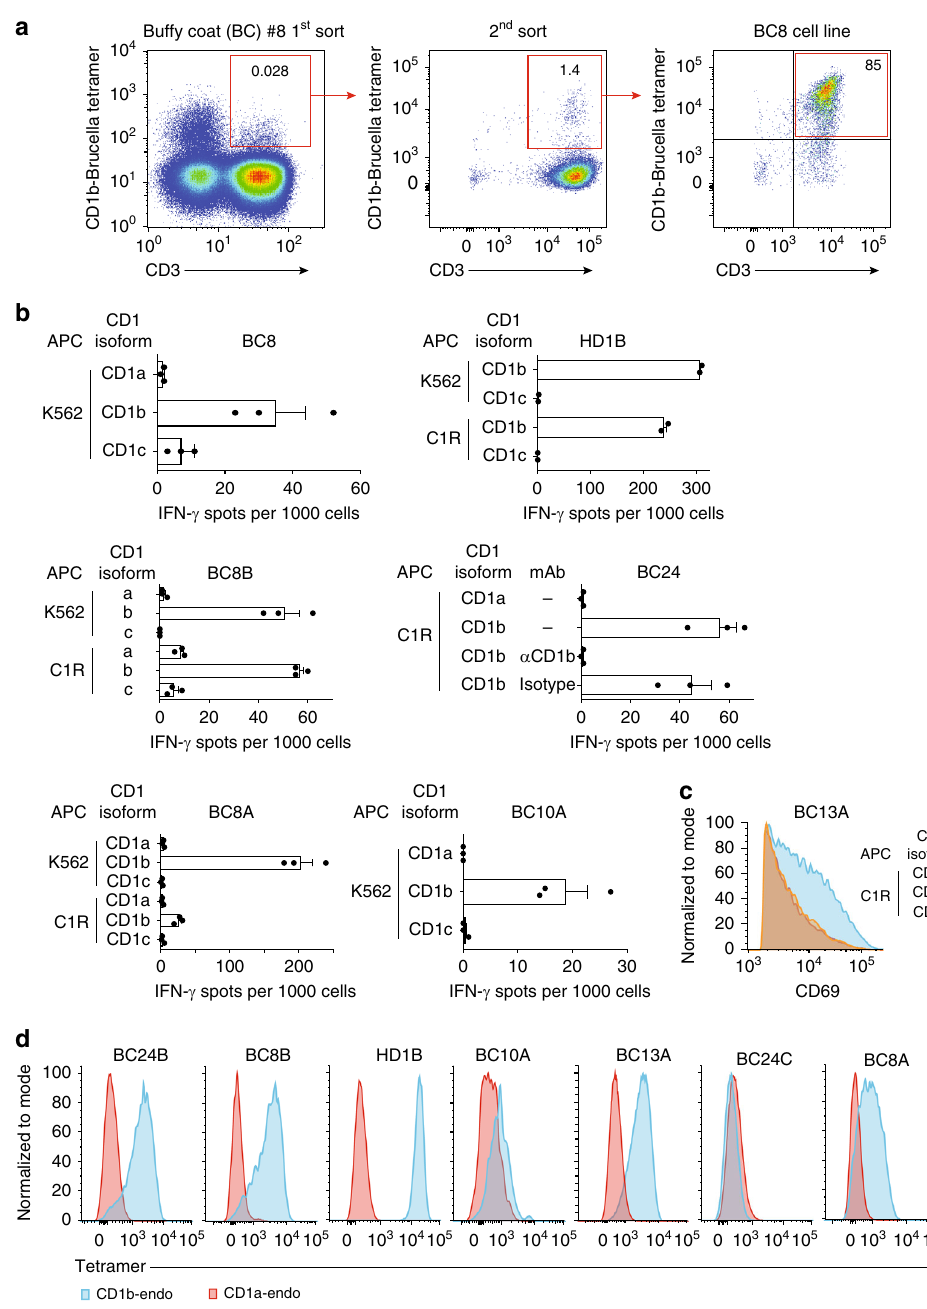
Fig. 1 CD1b tetramer selection generates autoreactive T-cell lines. a Peripheral blood mononuclear cells from blood bank-derived buffy coat 8 (BC8) were sorted based on expression of CD3 and binding to CD1b tetramers treated with Brucella lipid extract, followed by expansion in vitro. Numbers in the outlined red areas indicate percent cells in gate. The generation of additional T-cell lines is shown in Supplementary Figures 1 – 5. b IFN- γ ELISPOT assay of T-cell lines and subpopulations stimulated with K562 or C1R cells transfected to express CD1a, CD1b, or CD1c in the absence of exogenously added antigen. Error bars represent standard error of the mean (SEM) of triplicate wells. c Jurkat cells transduced to express the BC13A TCR were stimulated with C1R cells transfected to express CD1a, CD1b, CD1c in the absence of exogenously added antigen. After 24 h, CD69 expression was determined by fl ow cytometry. d Polyclonal T-cell populations from the indicated donor were stained with CD1a-endo or CD1b-endo tetramers. T-cell line derivation ( a ) and screening ( b , d ) was performed once on each of fi ve donors. The experiments in c were performed twice with comparable results. APC antigen-presenting cell